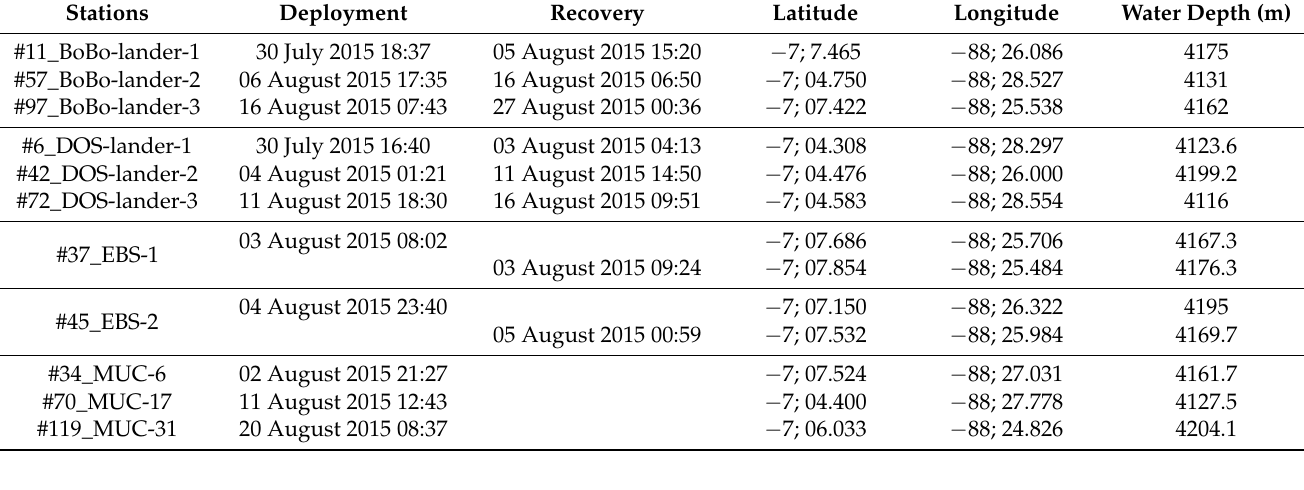
Table 1. Overview of lander deployments and EBS disturbance test during SO242.